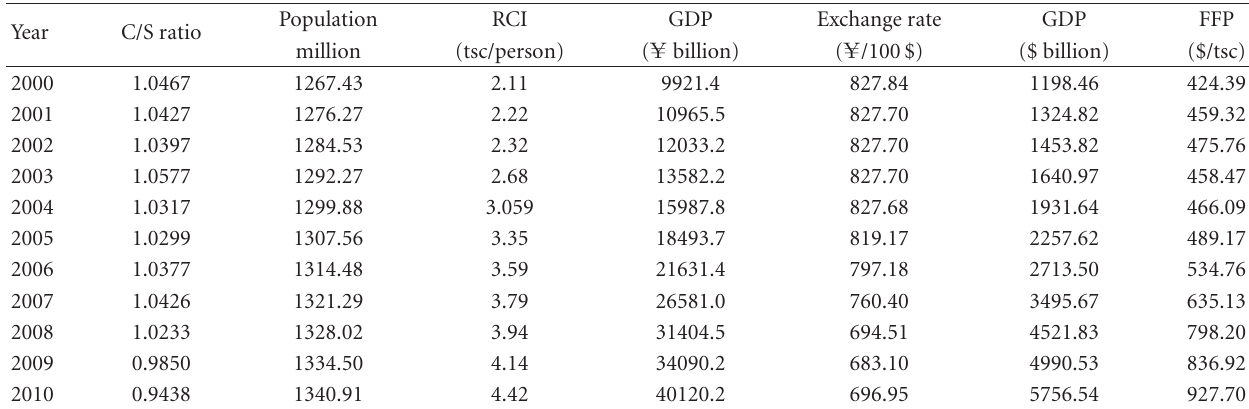
Table 5: C/S ratio, RCI, and FFP of China during 2000–2010.